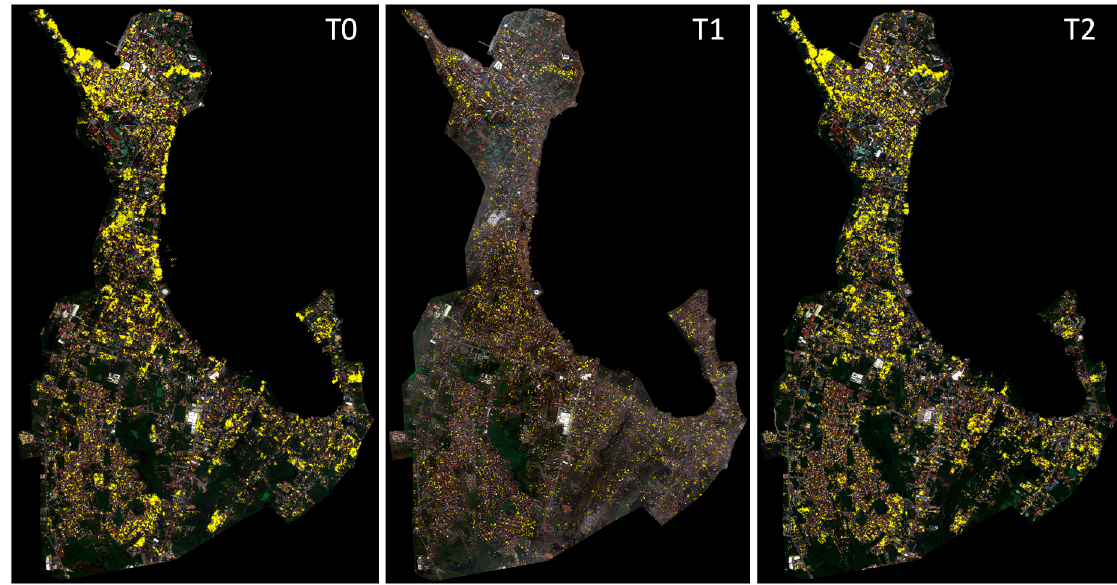
Figure 4. Detected slum areas, denoted in yellow color, for before (T0), 3 days after (T1), and 4 years after (T2) Haiyan.